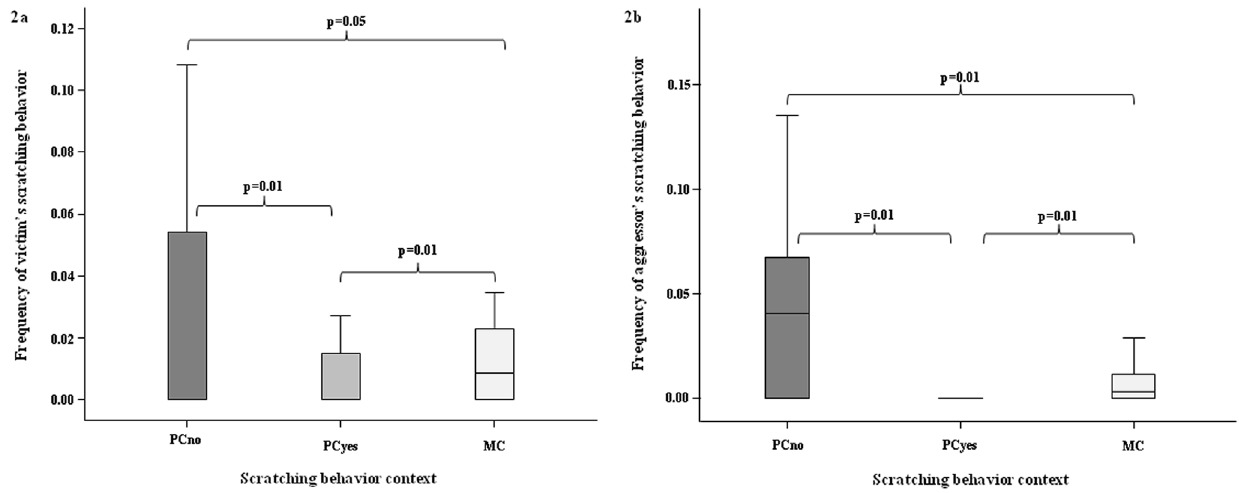
Figure 2. Scratching hourly frequency during post-conflict period with no reconciliation (PCno), post-conflict period with reconciliation (PCyes), and control condition (MC) both in the victim (2a) and in the aggressor (2b). Solid horizontal lines indicate medians; length of the boxes corresponds to inter-quartile range; thin horizontal lines indicate range of observed values (minimum and maximum). Only significant results are reported.